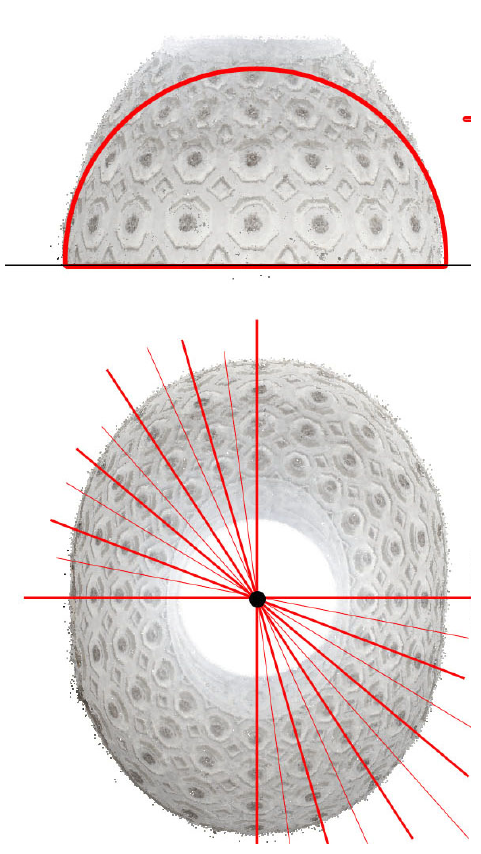
Figure 13. Dome of S.Giovanni Maggiore in Naples. Coffers layout study.